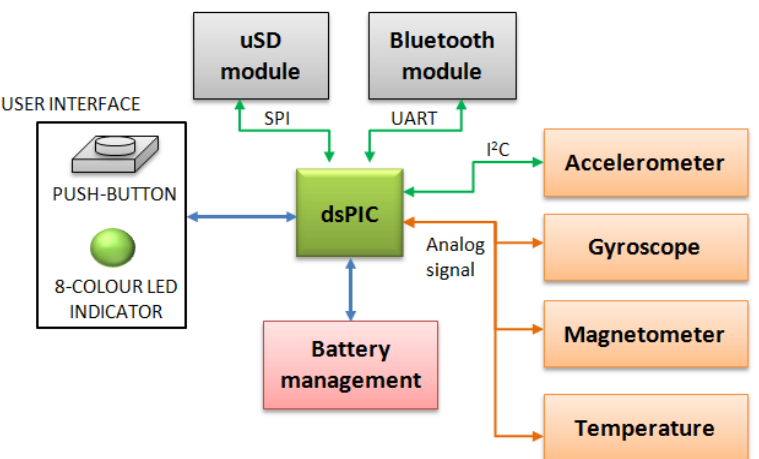
Figure 2. General block